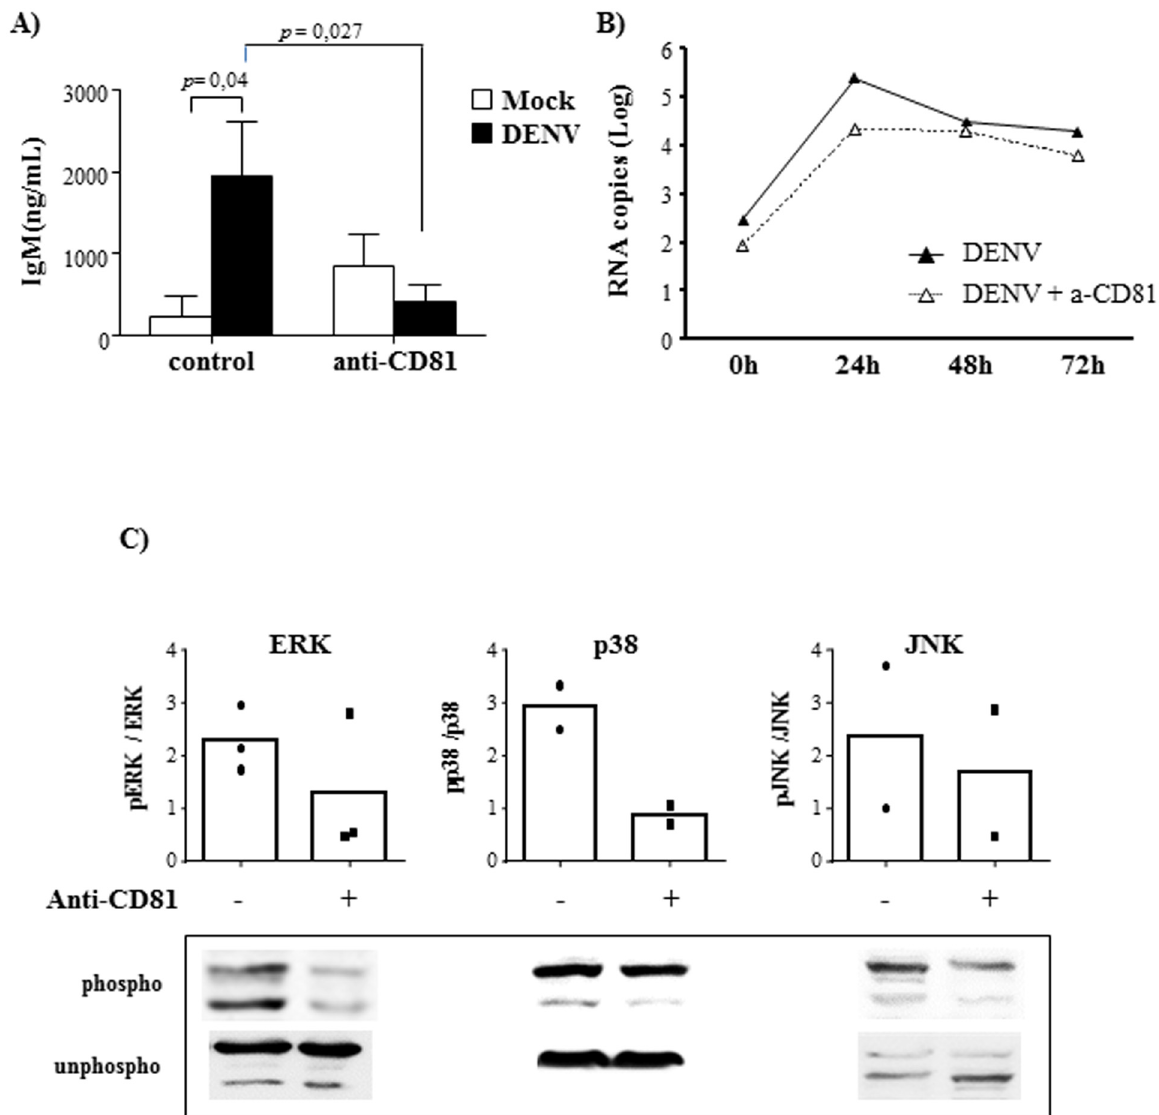
Fig 6. DENV-induced B cell activation depends on CD81 activation. B lymphocytes were mock-treated or cultured with DENV2 (MOI = 1) in the presence or absence of anti-CD81 neutralizing antibody. A) At 12 days post infection, the supernatants were harvested and IgM levels were measured by ELISA. Data are representative of four independent experiments. Statistical analysis were performed and p values are indicated in the figures. B) The cells were harvested after different time points and DENV RNA levels were evaluated by qRT-PCR. Data are representative of three independent experiments. C) After 48h, the cells were harvested and the expression of ERK, p38 and JNK MAPK, phosphorylated (phospho) or not (unphospho) were analyzed in the cell lysates by western blotting, as indicated. The bars indicate the ratio between the analyzed phosphorylated protein and the corresponding unphosphorylated one; dots represent individual